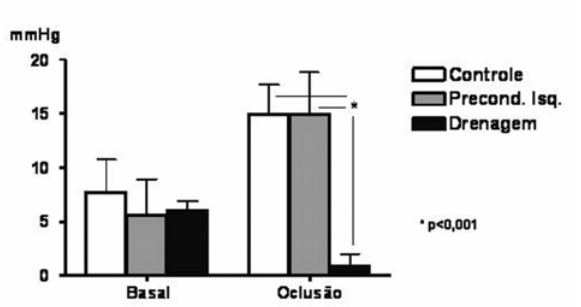
Fig. 3 - Pressão liquórica, antes e durante a oclusão da aorta, nos três grupos. Os valores estão expressos em média e desvio-padrão